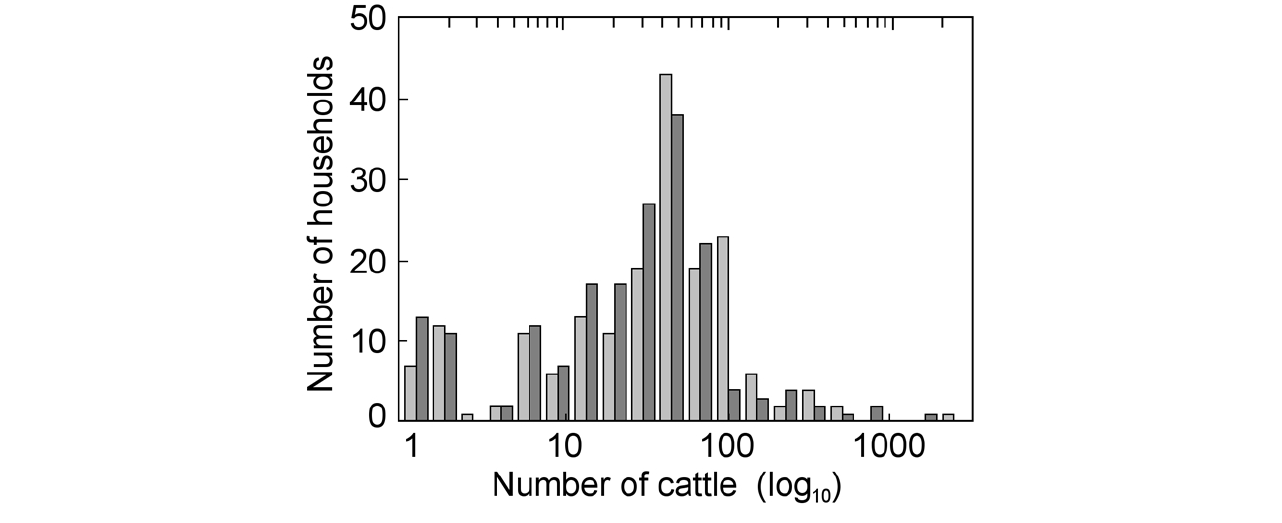
Fig. 5 . The number of individual households with cattle holdings in bins (with varying dimensions when scaled to log10), of the 184 with results reported in detail. The histogram shows the baseline holdings (light bars) and holdings in July following a two-year drought (dark bars). Drought conditions reduced livestock holdings, and essentially shifted the density histogram toward lower